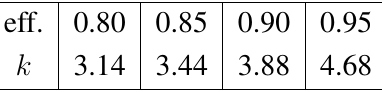
Table 1. Efficiency of the bisquare algorithm for several values of the parameter k [19].